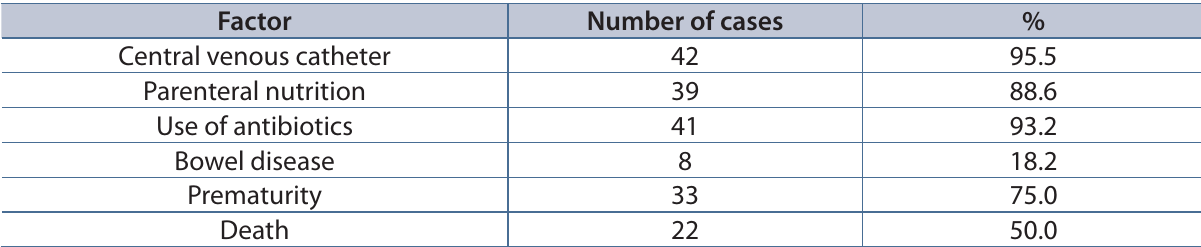
Table 8. Factors associated with candidemia in patients under one year old admitted to Botucatu Medical School University Hospital